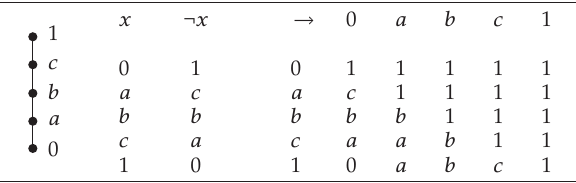
Table 1: Hasse diagram and Cayley